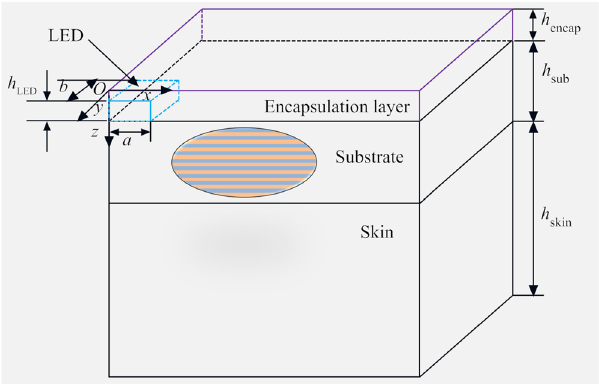
Figure 1. Schematic structure of the µ -ILED device on a layered orthotropic substrate integrated with human